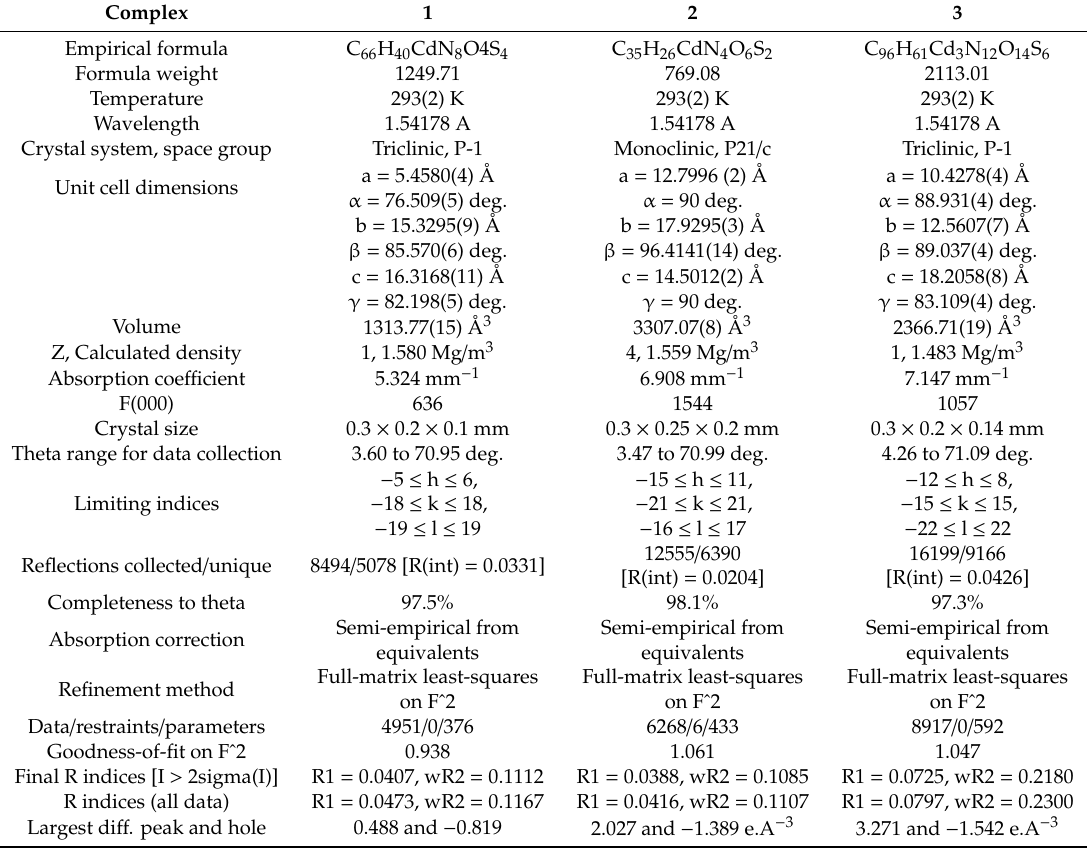
Table 1. Crystal data and structure refinement for 1 , 2 , and 3